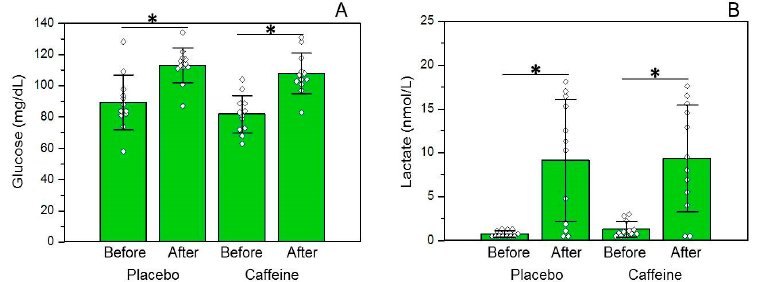
Figure 2. Blood glucose and lactate concentrations before and after the trials. ( A ) blood glucose concentrations ( n = 12) and ( B ) blood lactate concentrations ( n = 12). * was considered different from baseline. Data are expressed as means ± standard deviation.